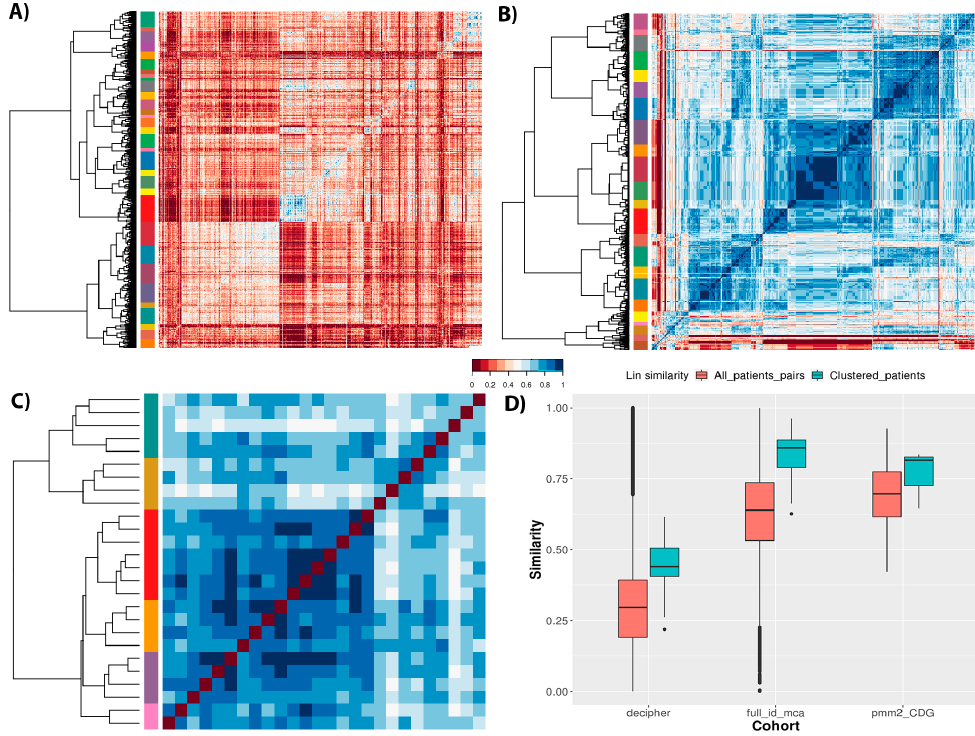
Figure 6. Heatmaps with patient similarity calculated with Lin similarity measure for each pair of profiles. The coloured column shows the patient groups identified by the clustering algorithm. Only patients with three or more HPO terms were used to build the similarity matrix. ( A ) DECIPHER, ( B ) ID/MCA, ( C ) PMM2-CDG. ( D ) Semantic similarity distribution for each cohort along the whole dataset (salmon boxes) or averaged for each cluster (blue